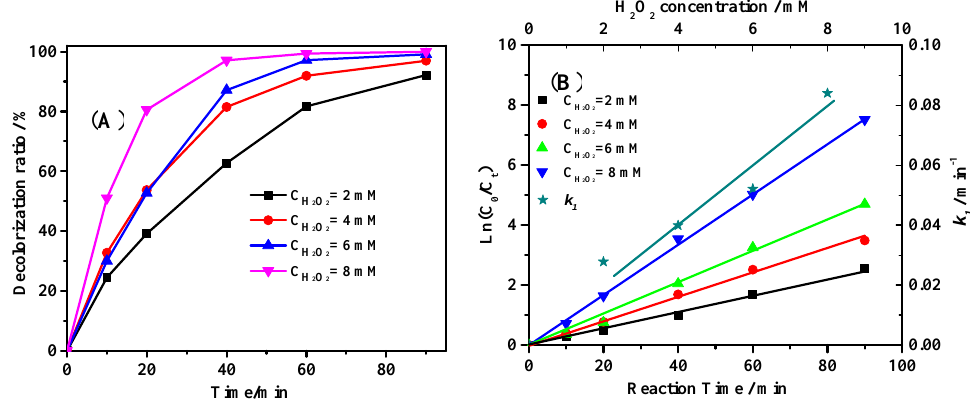
Figure 5. Effect of H 2 O 2 dosage on the degradation activity of ARG ( C 0 = 50 mg/L, pH = 2.50) ( A ), and the first order reaction simulation of the data ( B ).